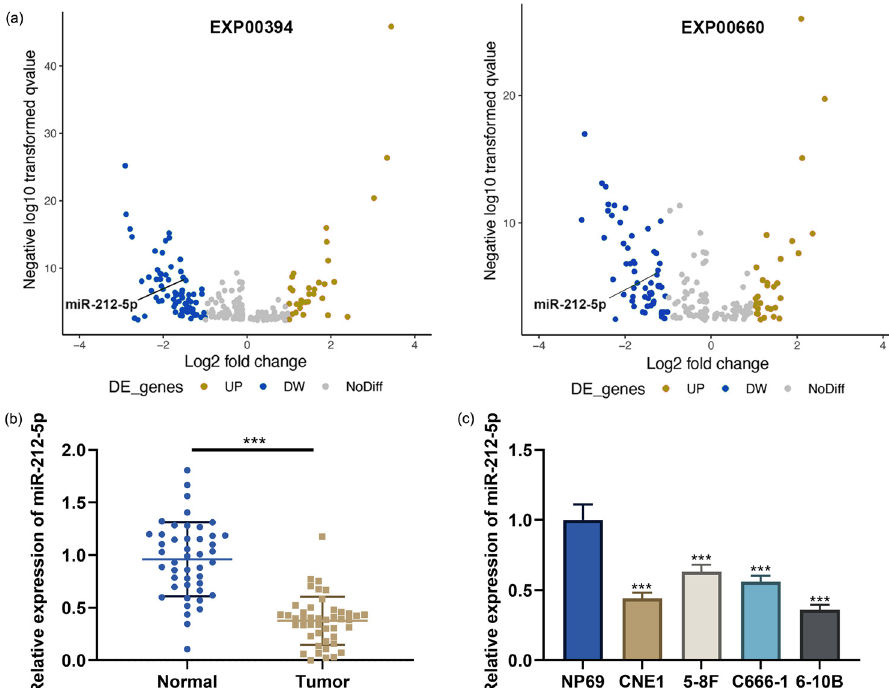
Figure 1: miR - 212 - 5p expression is inhibited in NPC tissues and cells. ( a ) Volcano plots: microarray datasets EXP00394 and EXP00660 were downloaded from the dbDEMC database to analyze the di ff erential expression of miRNAs between high - grade and low - grade NPC tissues. ( b ) miR - 212 - 5p expression in NPC tissues and adjacent tissues was detected by qRT - PCR. ( c ) miR - 212 - 5p expression in human normal nasopharyngeal epithelial cells NP69 cells and NPC cell lines ( CNE1, 5 - 8F, C666 - 1, 6 - 10B ) was detected by qRT - PCR. ***P <